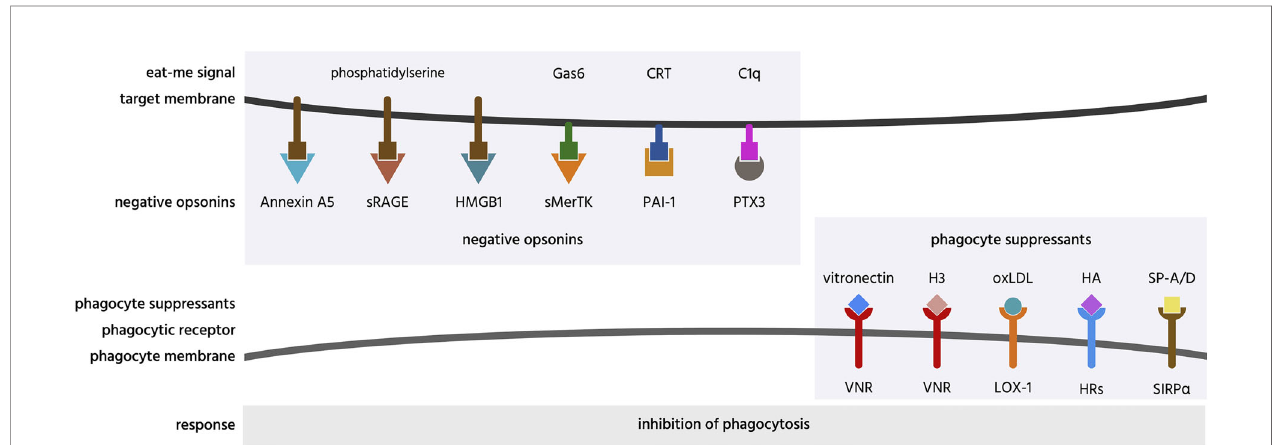
FIGURE 7 | Negative opsonins and phagocyte suppressants, and their potential mechanisms of action. Negative opsonins are extracellular proteins that, when bound to a target cell, inhibit phagocytosis of that cell by phagocytes; a phagocyte suppressant is a normally soluble, extracellular molecule, which, when bound to a phagocyte discourages it from phagocytosing targets. CRT, calreticulin; H3, histone H3; HA, hyaluronic acid; HMGB1, high mobility group box 1 protein; HRs, hyaluronic acid receptors; LOX-1, lectin-like OxLDL receptor 1; oxLDL, oxidised low-density lipoprotein; PAI-1, plasminogen activator inhibitor-1; PTX3, pentraxin 3; SIRP a , signal regulatory protein a ; sMerTK, soluble Mer tyrosine kinase; sRAGE, soluble receptor for advanced glycation end products; SP, surfactant protein; VNR, vitronectin